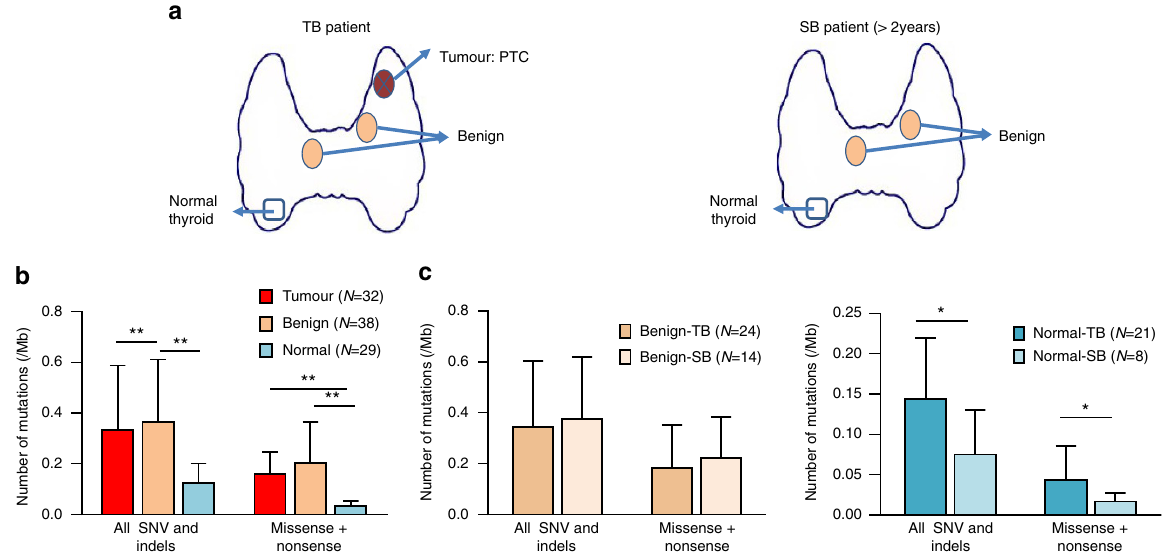
Figure 1 | Overview of somatic mutations in thyroid tissues. ( a ) Sampling schematic: Tissue samples were obtained from the thyroids of patients with or without PTC ( 4 2 years follow-up). Sample Groups TB: benign nodule with concurrent PTC; SB: simple benign nodule without concurrent PTC. Normal tissues were at least 2cm distant from the lesion foci. ( b ) Comparison of number of somatic mutations in PTCs, benign nodule and normal thyroid. Non- synonymous mutations included missense, stopgain SNV and indels. Mean ± s.d., ** P o 0.01 Wilcoxon signed-rank test. ( c ) Comparison of number of somatic mutations in benign nodules from TB and SB patients, as well as normal thyroid from TB and SB patients. Mean ± s.d., * P o 0.05 by Wilcoxon signed-rank